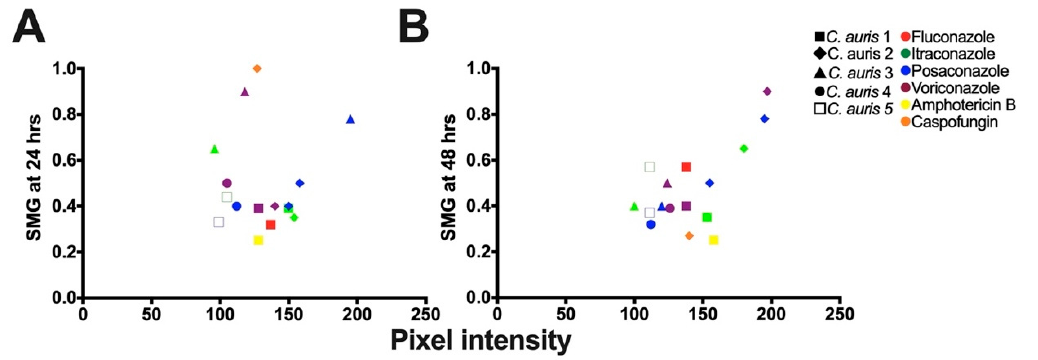
Figure 4. Correlation analysis for mean supra-MIC growth (SMG) and mean pixel intensity measured by ImageJ [51] to determine tolerance. ( A ) Analysis performed after 24 h of growth (R 2 = 0.3128; Pearson correlation test, p = 0.0469). ( B ) Analysis performed after 48 h of growth (R 2 = 0.2862; Pearson correlation test, p = 0.0085).